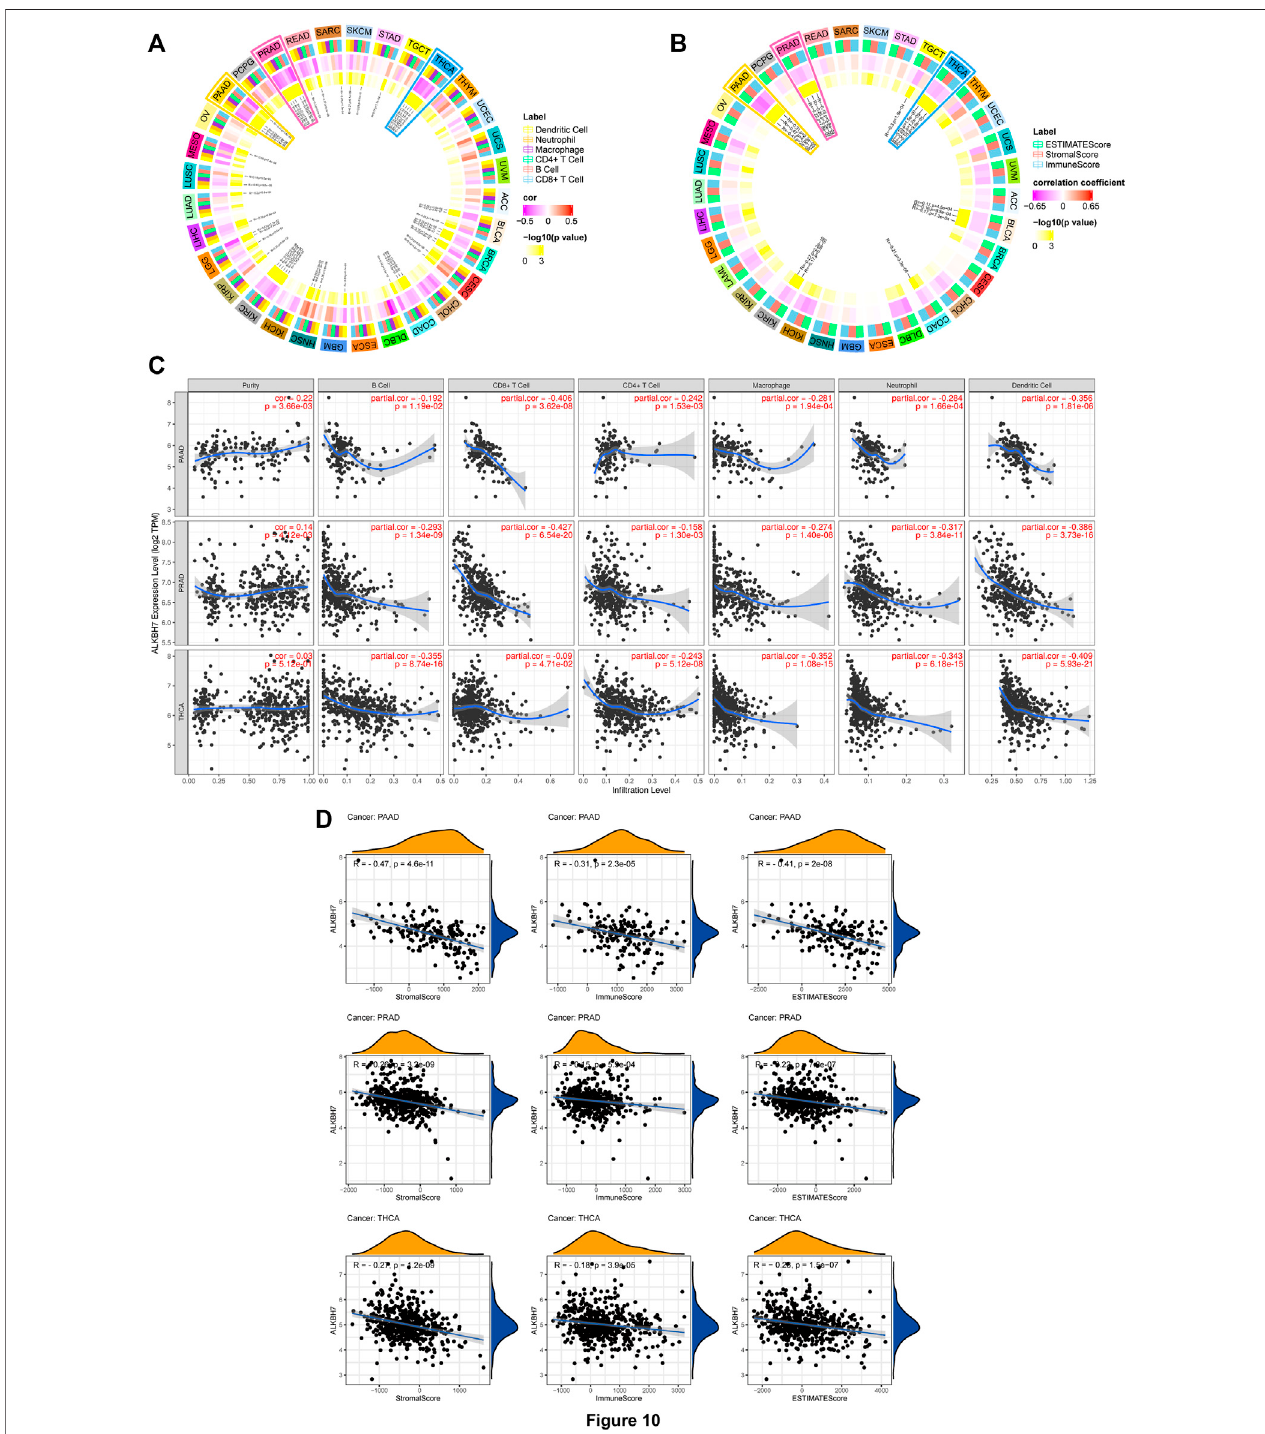
FIGURE 10 | Correlations between ALKBH7 expression and both immune cell in fi ltration and ESTIMATE score. (A) The relationship between the ALKBH7 expression level and numbers of in fi ltrating B cells, CD4 + T cells, CD8 + T cells, macrophages, neutrophils, dendritic cell in human cancers. (B) The relationship between ALKBH7 expression and the ESTIMATE score in human cancers. (C) Correlation of ALKBH7 expression with immune cell in fi ltration levels in PAAD, PRAD, and THCA. (D) Correlation of ALKBH7 expression with ESTIMATE scores in PAAD, PRAD, and THCA.